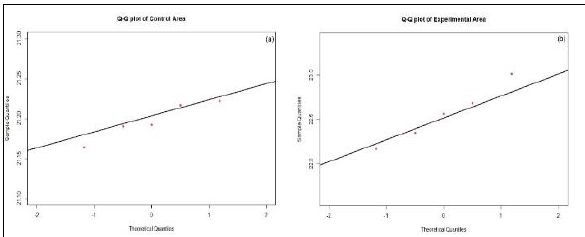
Figure 11. Q-Q plot to show the normality of the data of (a) control region and (b) test region.